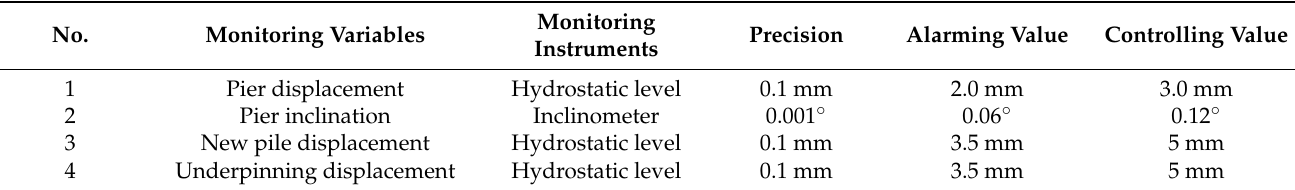
Table 4. Field monitoring variables and corresponding alarming and controlling